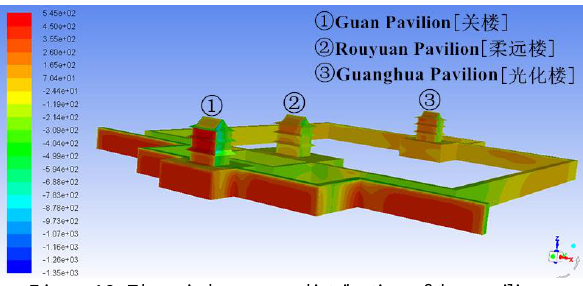
Figure 13. The wind pressure distribution of the pavilions As can be seen from figure 13, the wind pressure on the windward side of Guan Pavilion [ 关楼 ] is the biggest in these pavilions, 0.545 KN/m 2 ; the wind pressure of Guanghua Pavilion